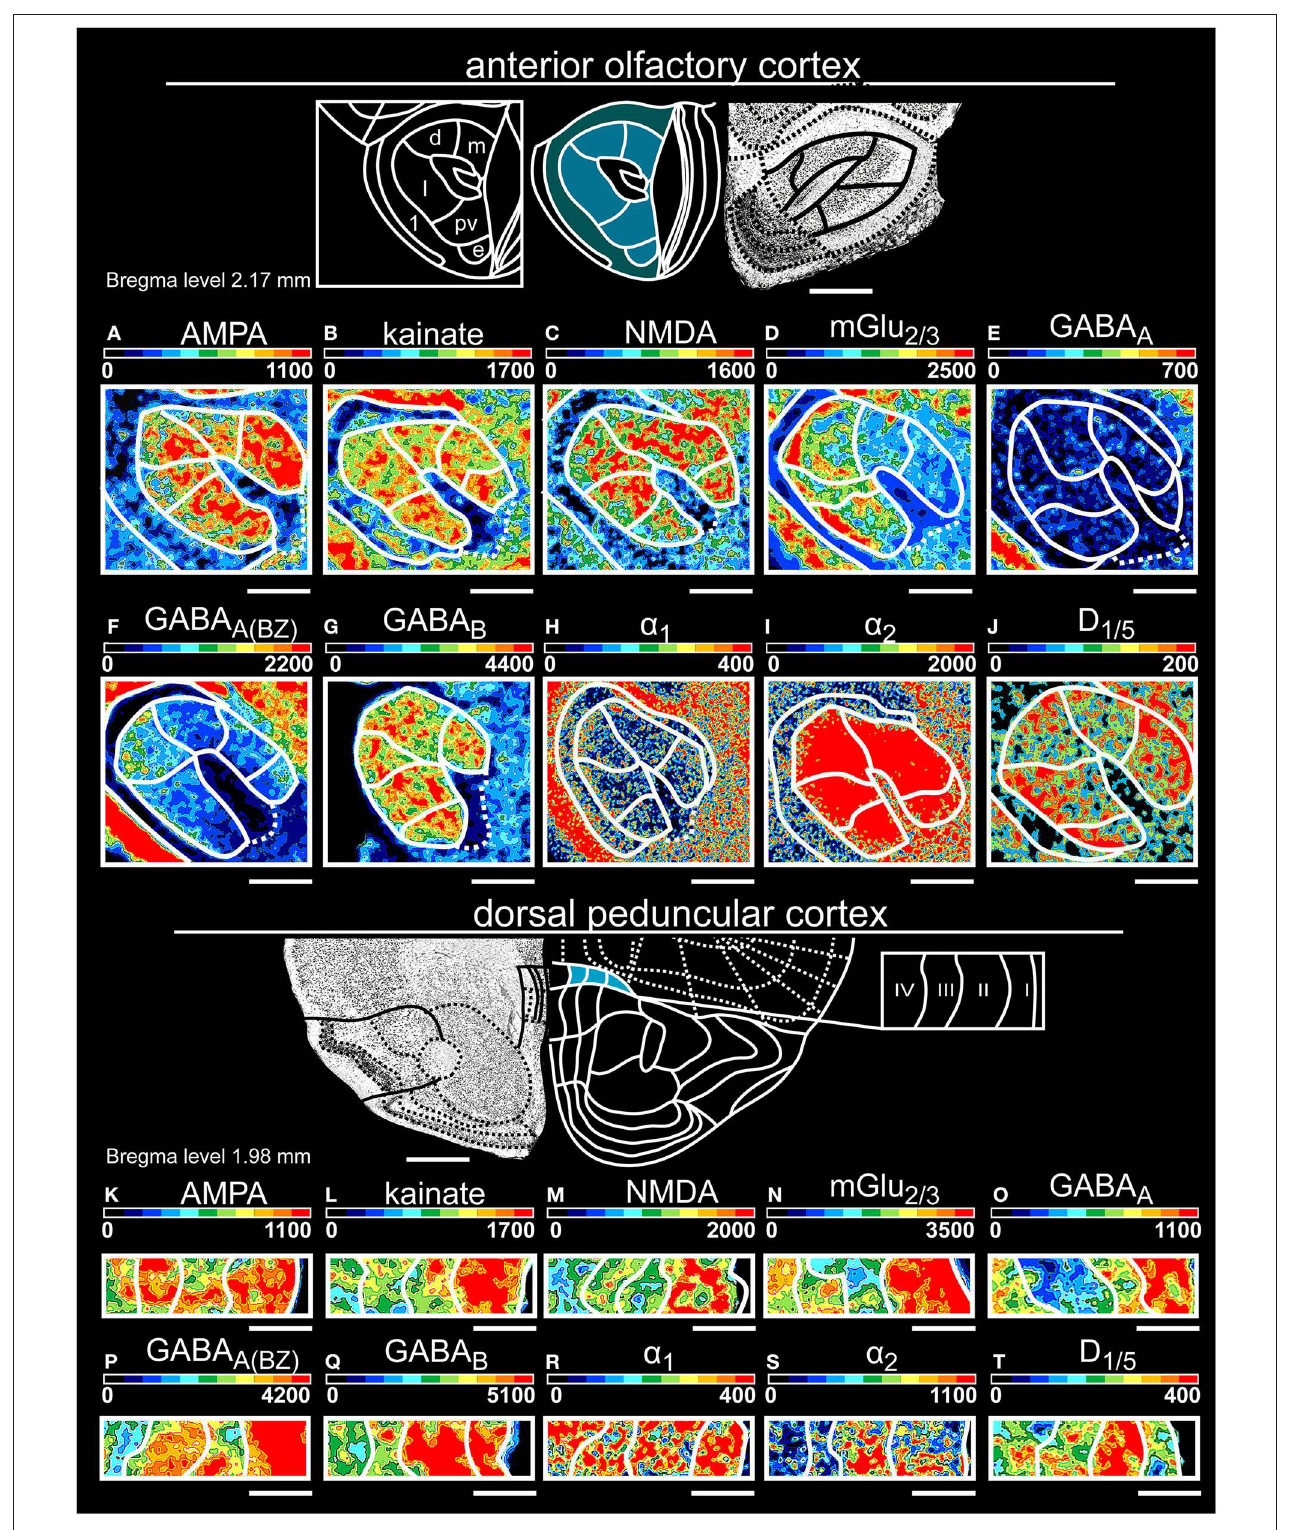
FIGURE 4 | Color-coded autoradiographs showing the distribution and density of all investigated receptors of the anterior olfactory cortex (A–J) and dorsal peduncular cortex (K–T) . Densities of the color-coded autoradiograms in fmol/mg protein according to color scales. For detailed receptor densities see Table 1 . Scale bars: Atlas, 800 µ m; (A–J) , 600 µ m; (K–T), 200 µ m; m, medial; d, dorsal; l, lateral; pv, posteroventral; 1, pars externa. I, layer 1; II, layer 2; III, layer 3; IV, layer